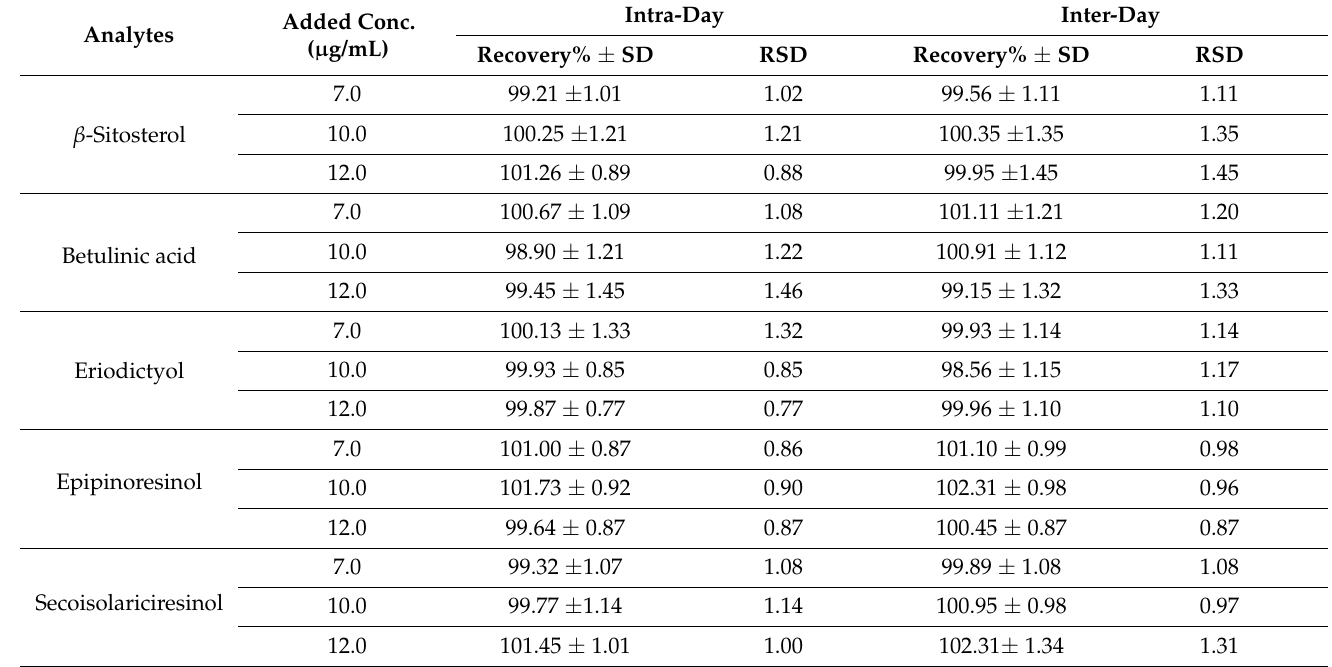
Table 2. Accuracy and precision of the proposed GC-MS/MS method for quantification of β -sitosterol, betulinic acid, eriodictyol, epipinoresinol, and secoisolariciresinol.